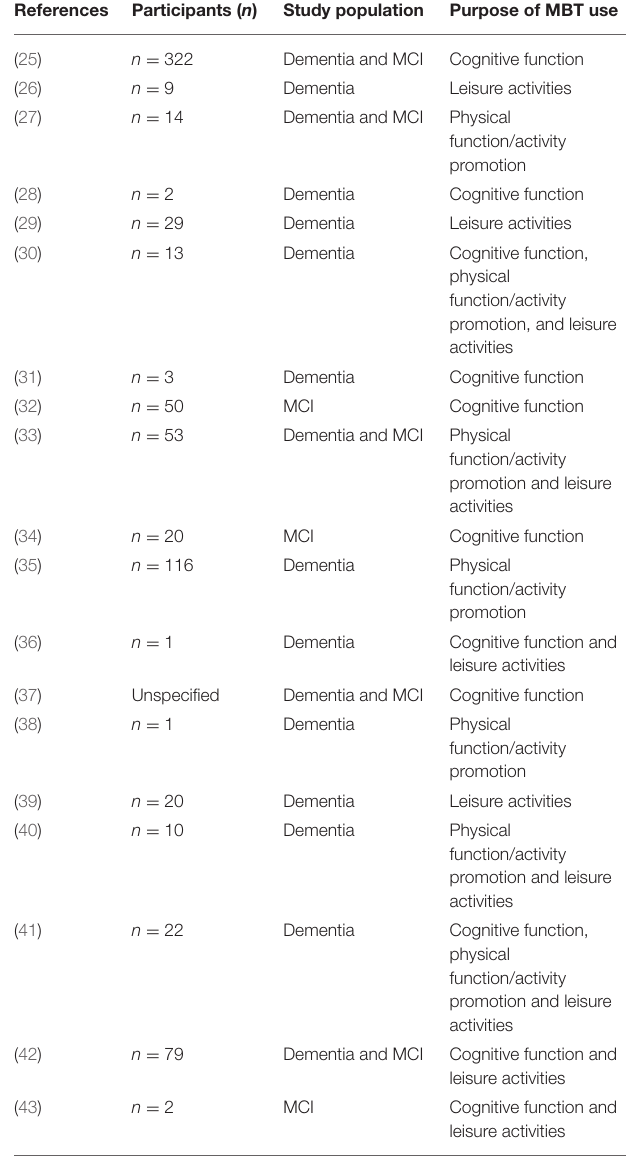
TABLE 1 | Summary of articles identified for inclusion. TABLE 2 | Summary of motion-based technology design features for people with dementia and